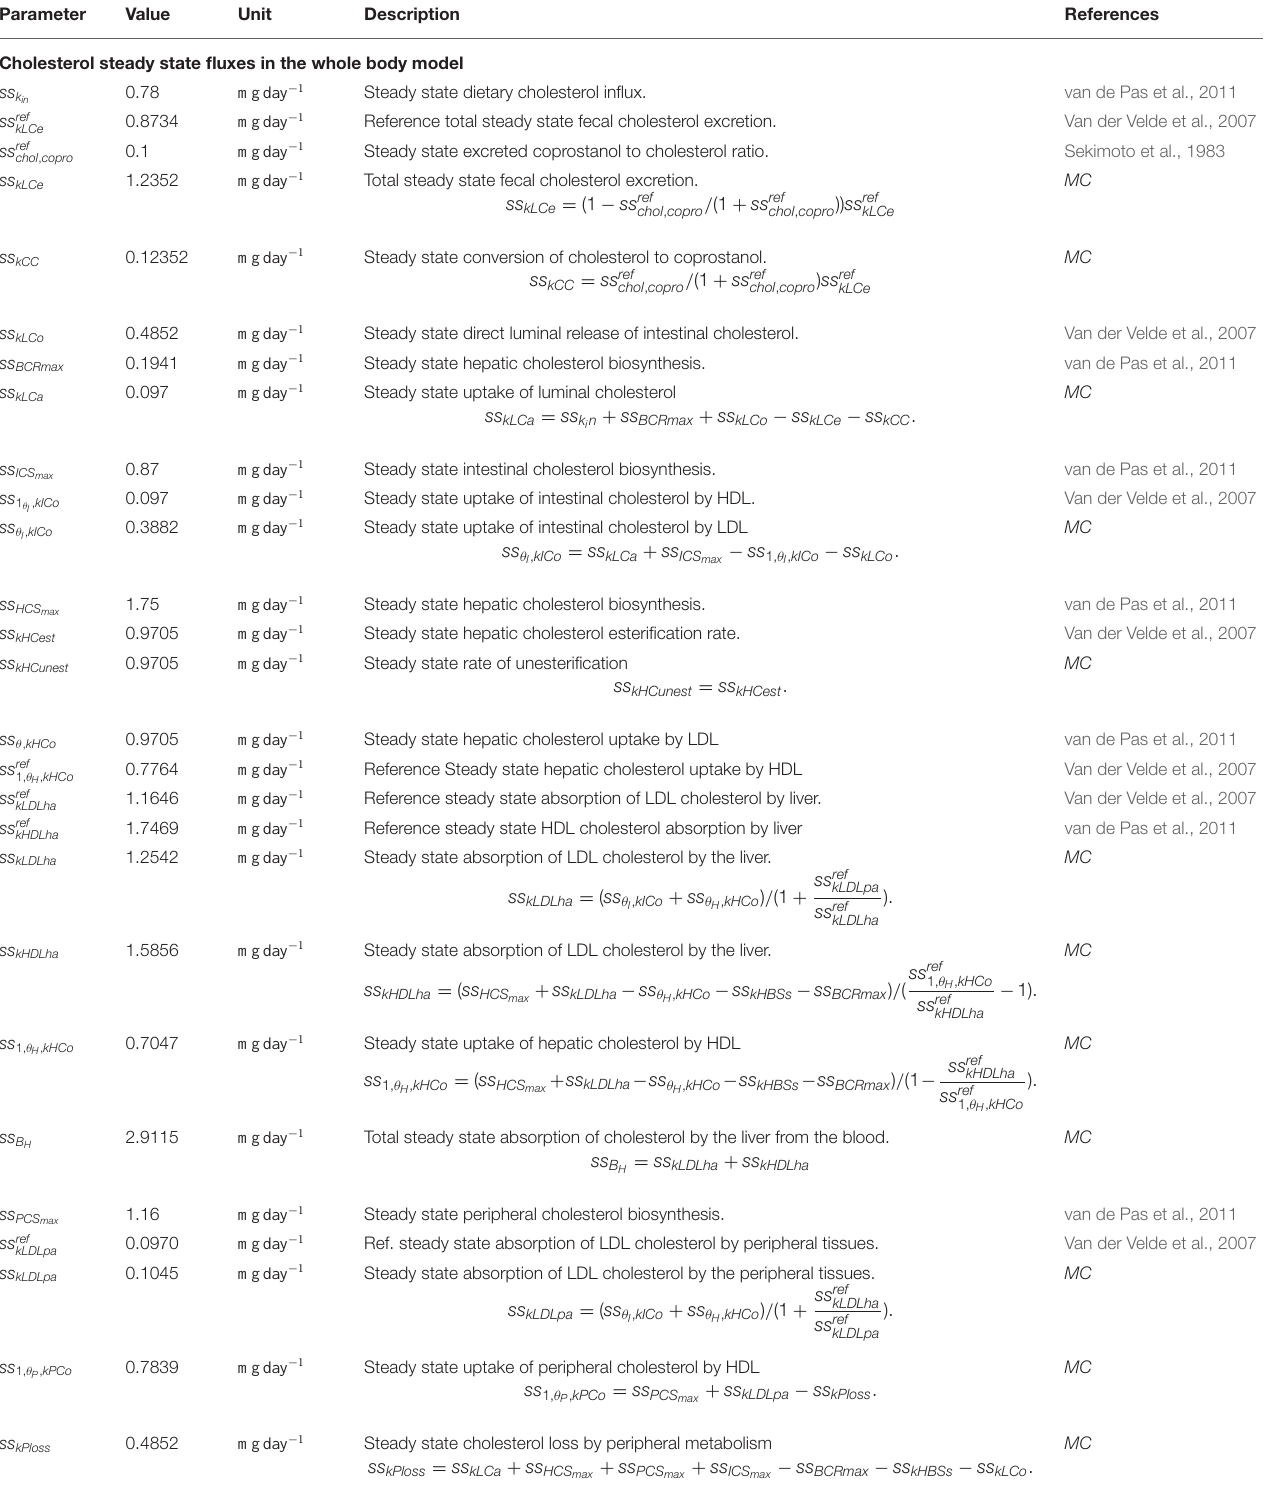
TABLE 2 | Parameters used for the calibration of the whole-body cholesterol cycle. Parameter